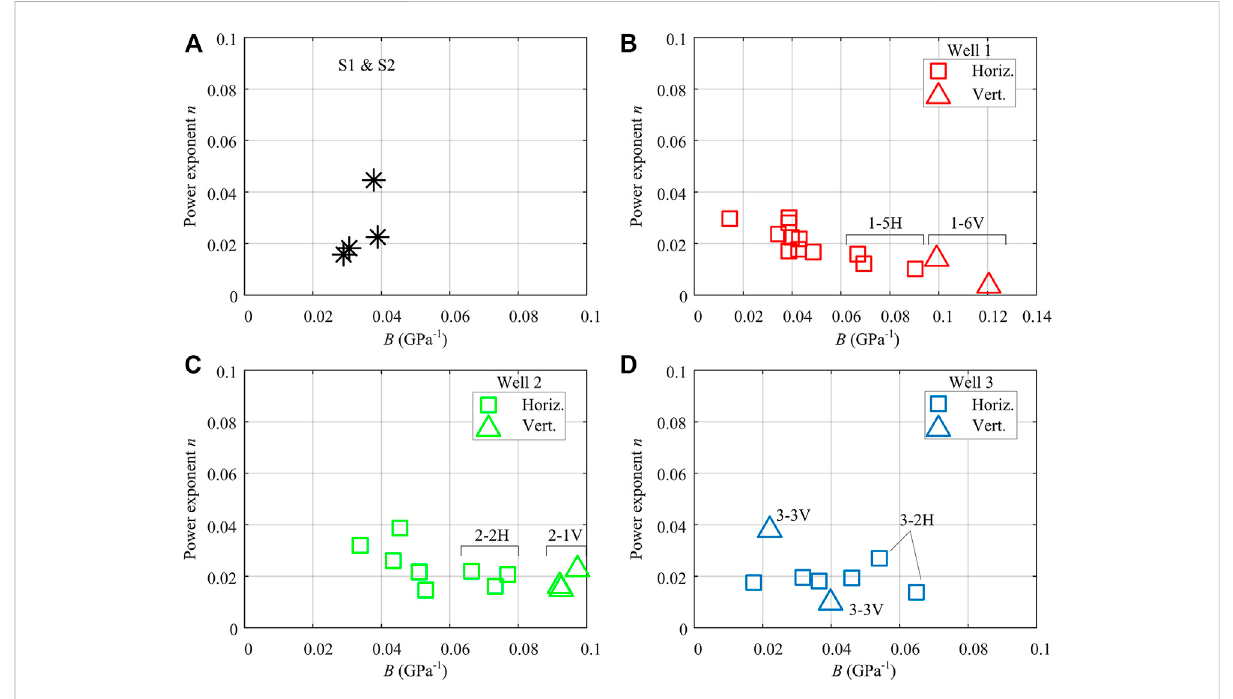
FIGURE 8 Summary of the constitutive parameters of all shale samples.